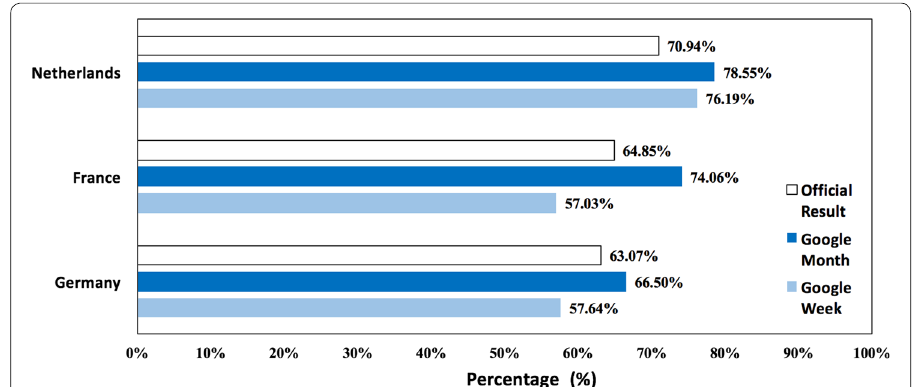
Fig. 9 Comparisons of the official Turkish Referendum results with Google hits for France, Germany, and the